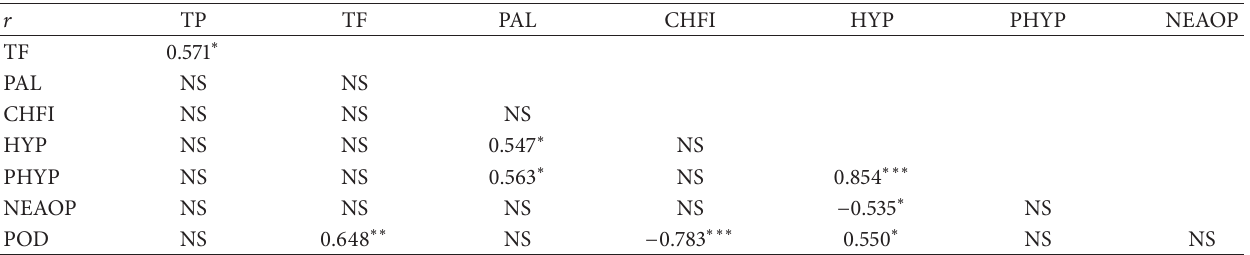
Table 1: Correlation analysis between secondary metabolite productions and antioxidant activities in Hypericum perforatum shoot